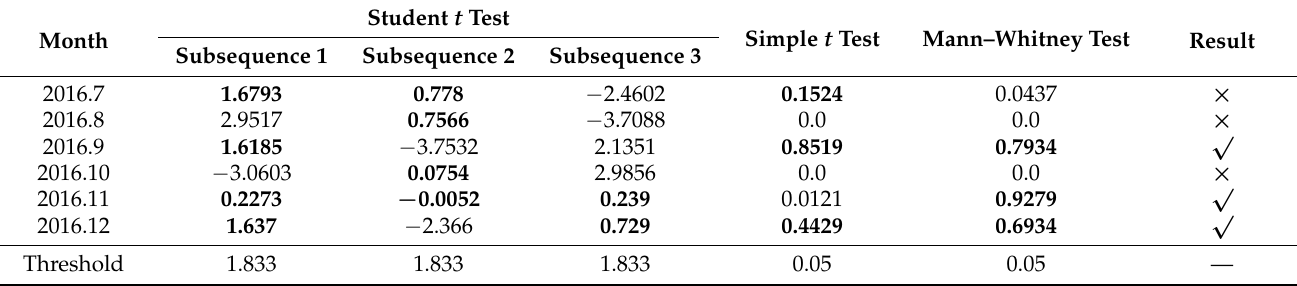
Table 4. Results of stationarity test.